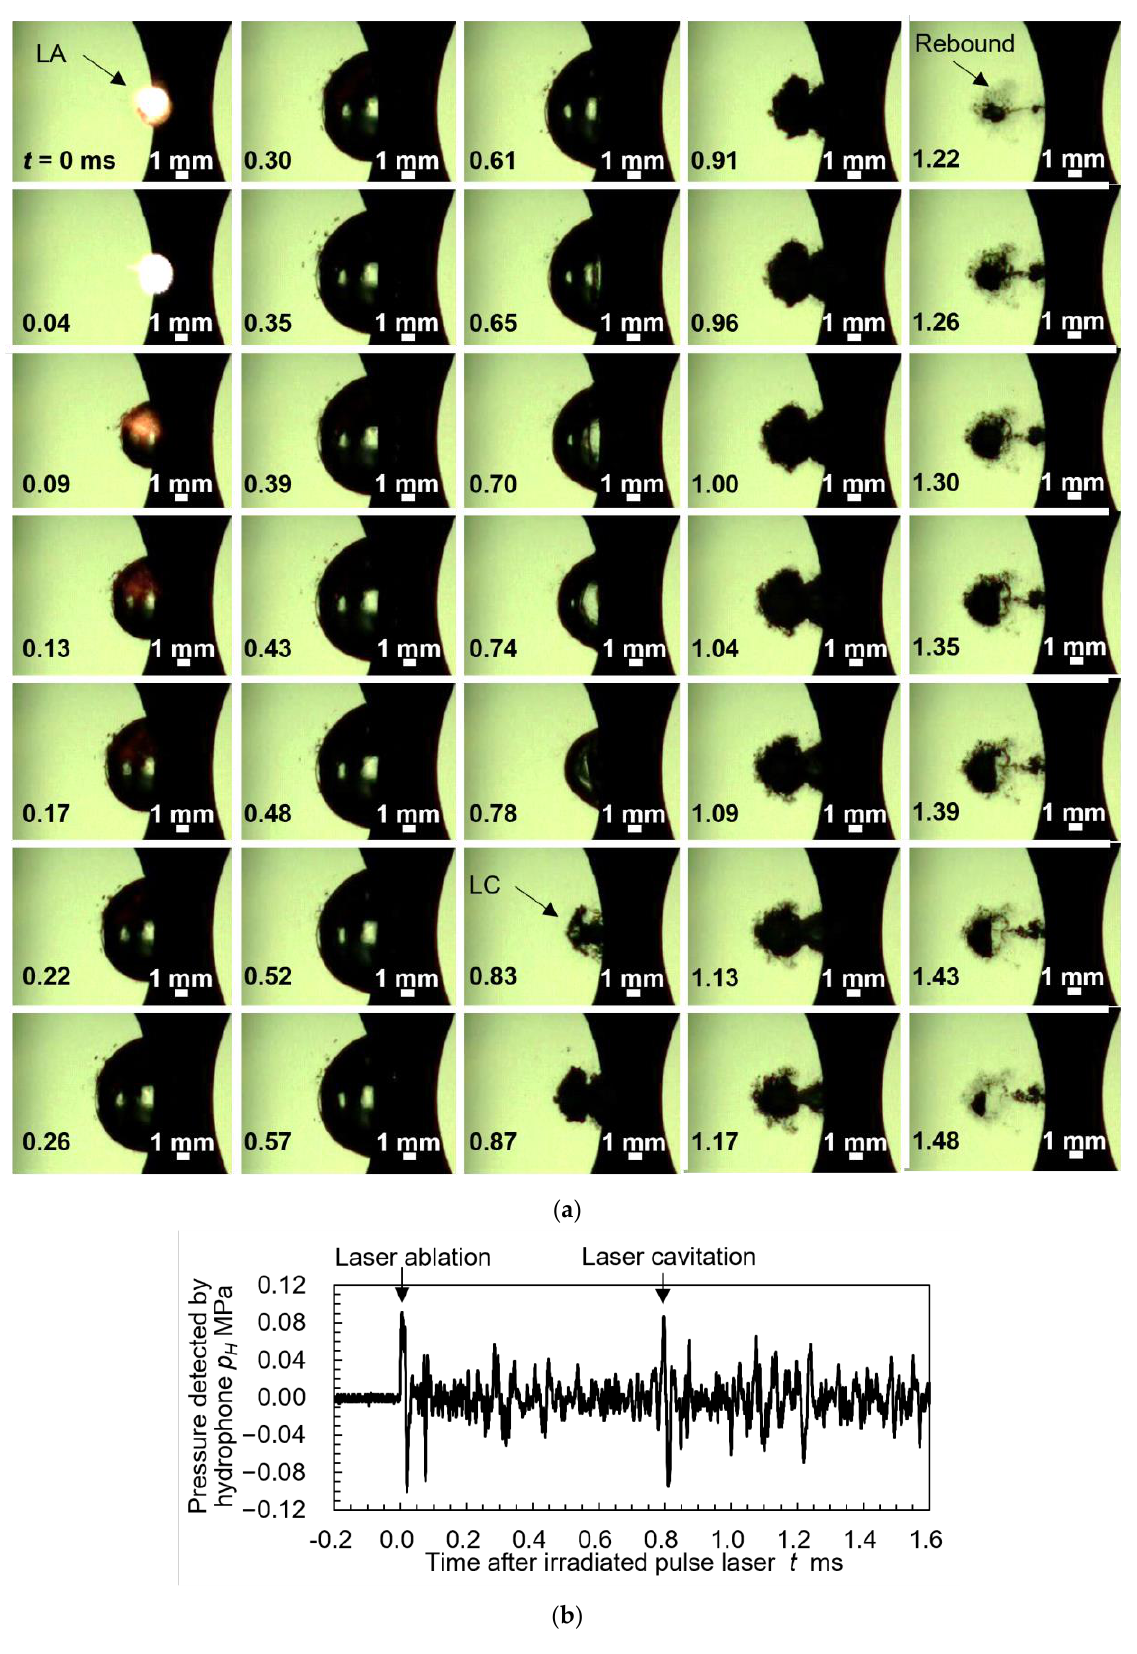
Figure 5. Laser ablation and laser cavitation induced by single pulsed laser: ( a ) aspects of laser ablation and laser cavitation; ( b ) signal from hydrophone.